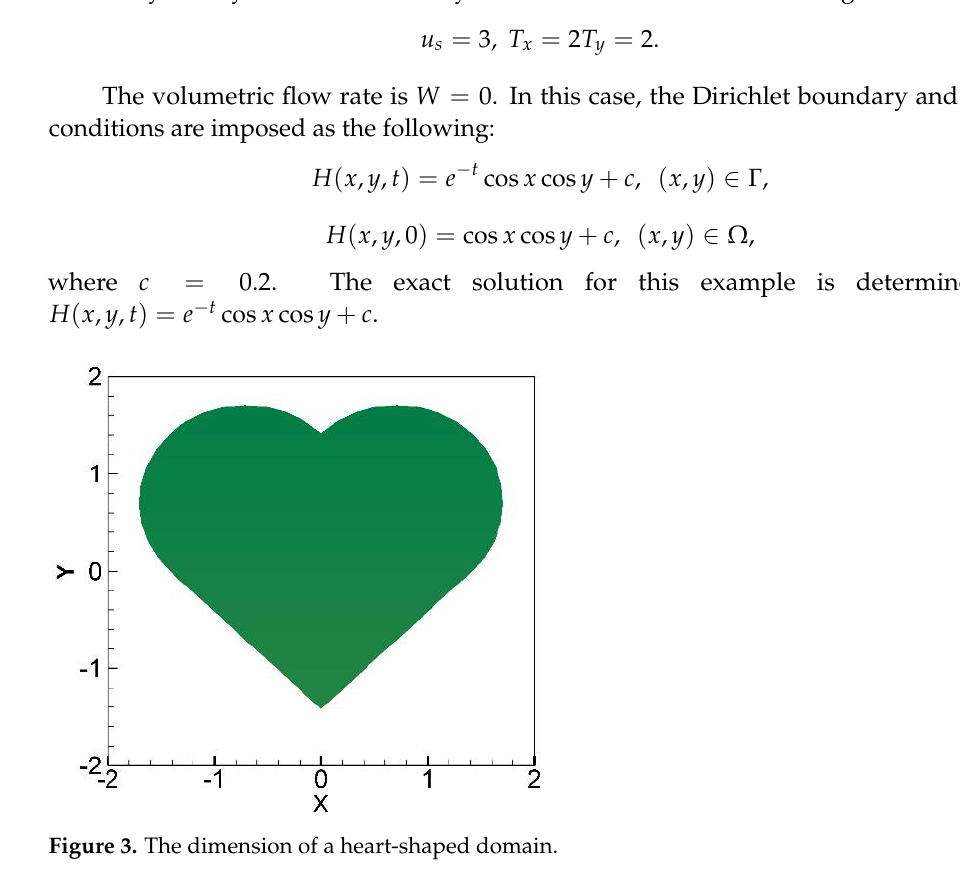
Figure 3. The dimension of a heart-shaped domain.